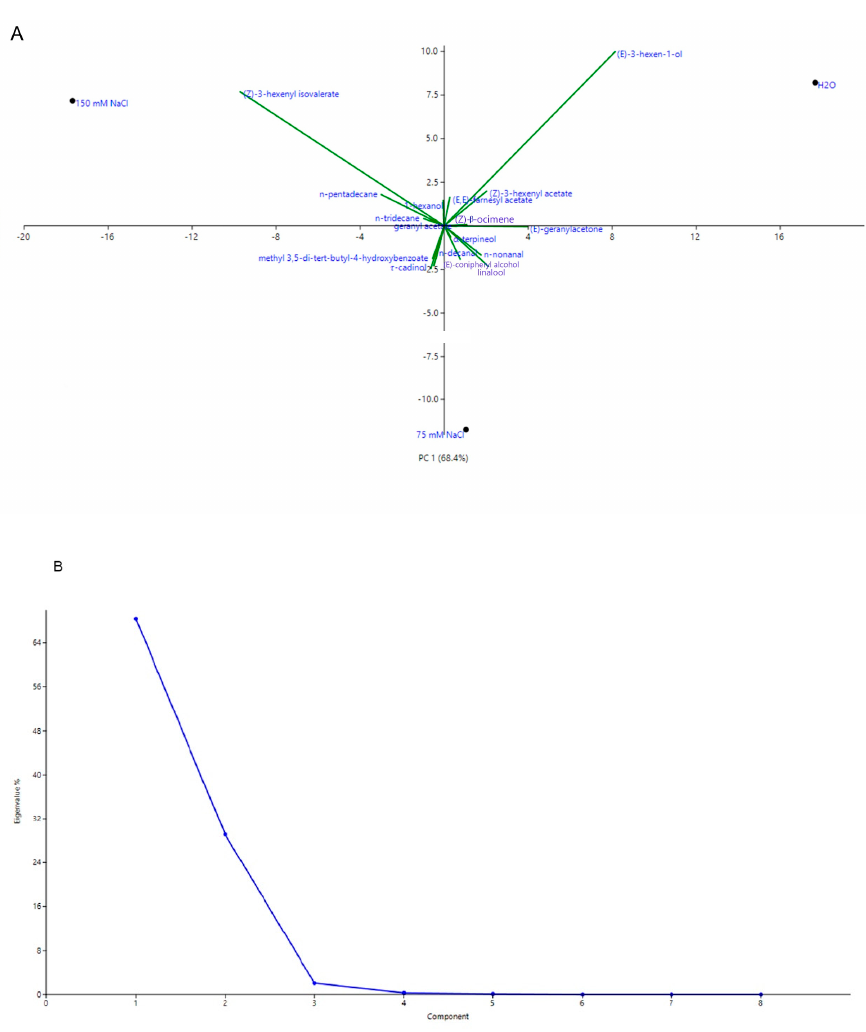
Figure 2. Scatter plot ( A ) and Scree plot ( B ) of the principal component analysis (PCA) of the volatile organic compounds (VOCs) at different gradient of salinity.